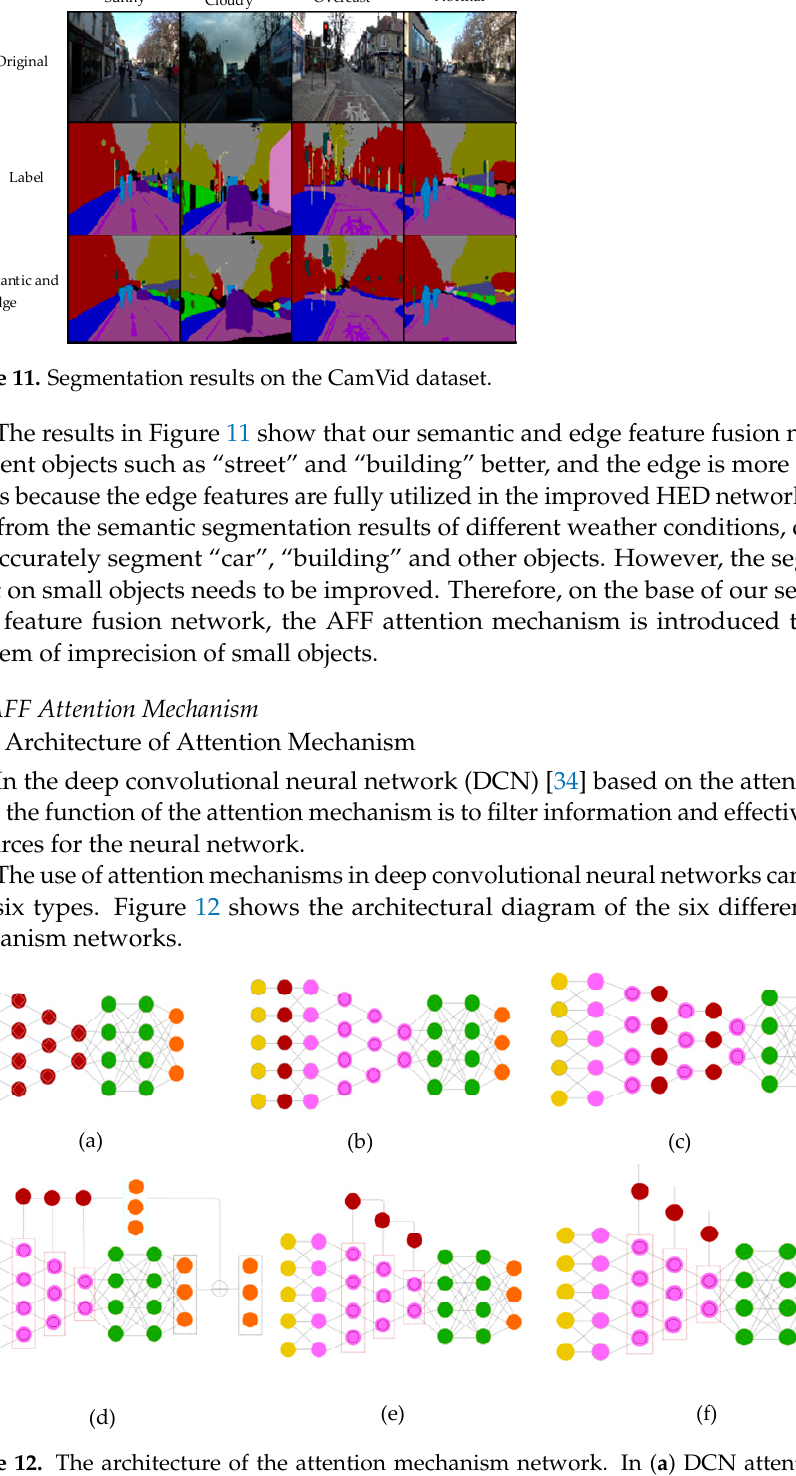
C  H  W Z Figure 13. Structure of the AFF attention mechanism.